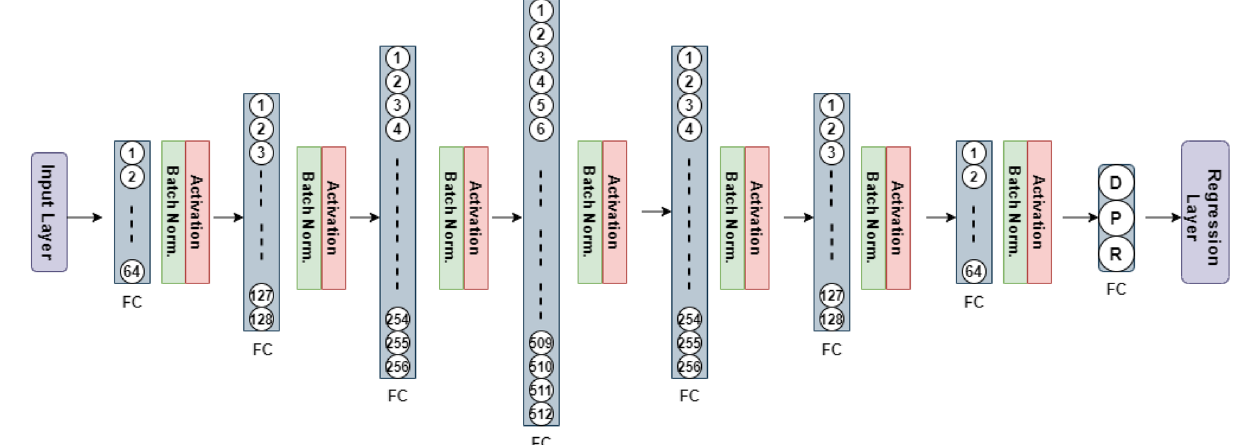
Figure 8. Architecture of the proposed M2LP framework.